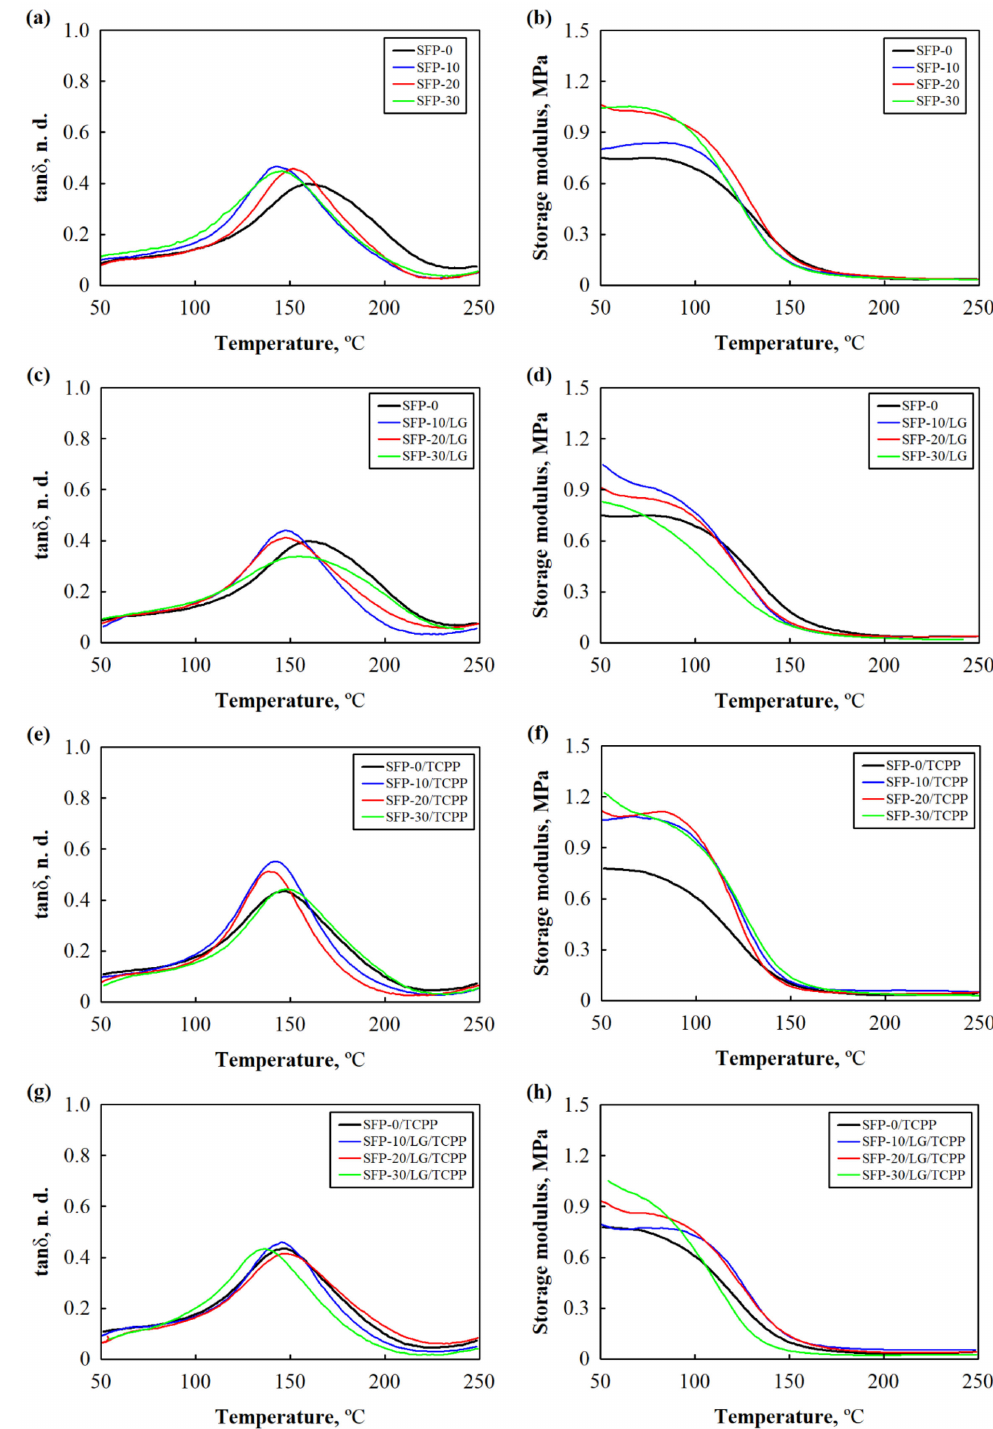
Figure 2. Dynamic mechanical analysis curves of PUR foam composites: ( a , c , e , g ) tan δ and ( b , d , f , h ) storage